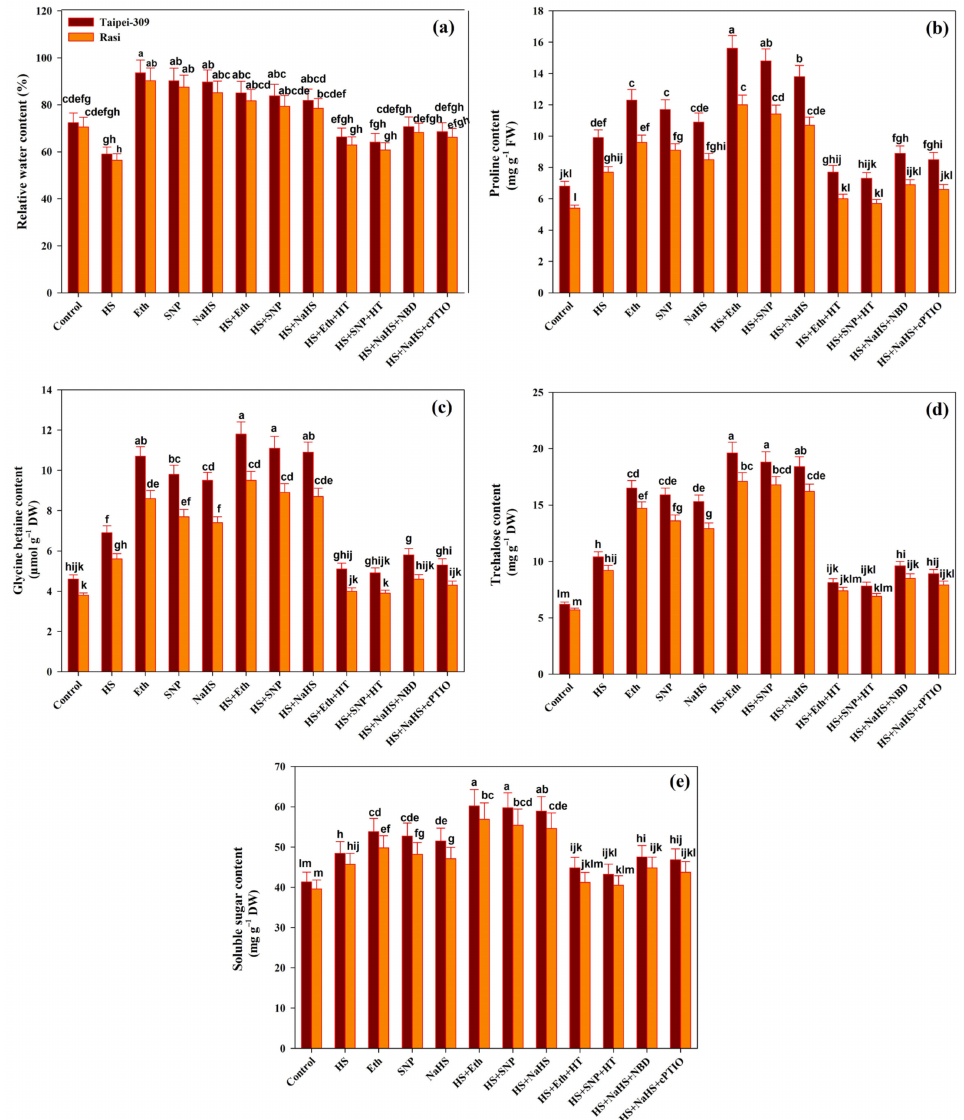
Figure 2. ( a ) Relative water content, ( b ) proline content, ( c ) glycine betaine content, ( d ) trehalose content, and ( e ) soluble sugars content of rice ( Oryza sativa L.) cultivars Taipei-309 and Rasi under control and high temperature stress (HS) supplied with 200 µ L L − 1 ethephon (Eth), 100 µ M sodium nitroprusside (SNP), 200 µ M sodium hydrosulfide (NaHS), or 100 µ M hypotaurine (HT), 100 µ M 2-4-carboxyphenyl-4,4,5,5 -tetramethylimidazoline-1-oxyl-3-oxide (cPTIO) or 100 µ M norbornadiene (NBD) scavengers of hydrogen sulfide (H 2 S), nitric oxide (NO), and ethylene action inhibitors, respectively. Data are presented as treatments mean ± SE ( n = 4). The values followed by the same letters did not differ significantly by LSD test at p <